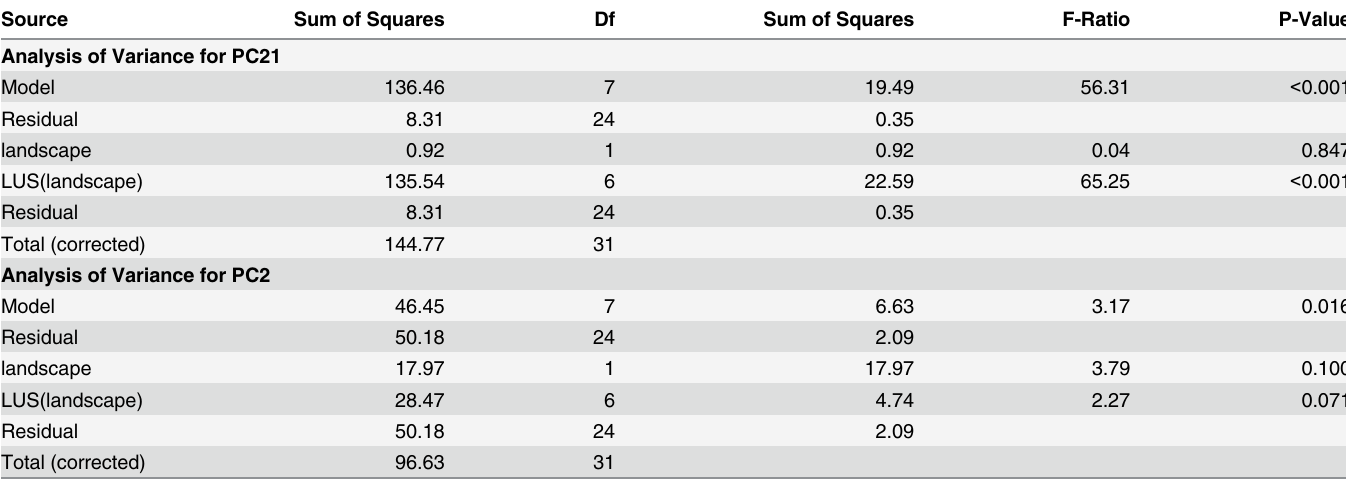
Table 3. General linear mixed model for PC1 and PC2 as dependent variables and landscape and land use system (LUS) as categorical